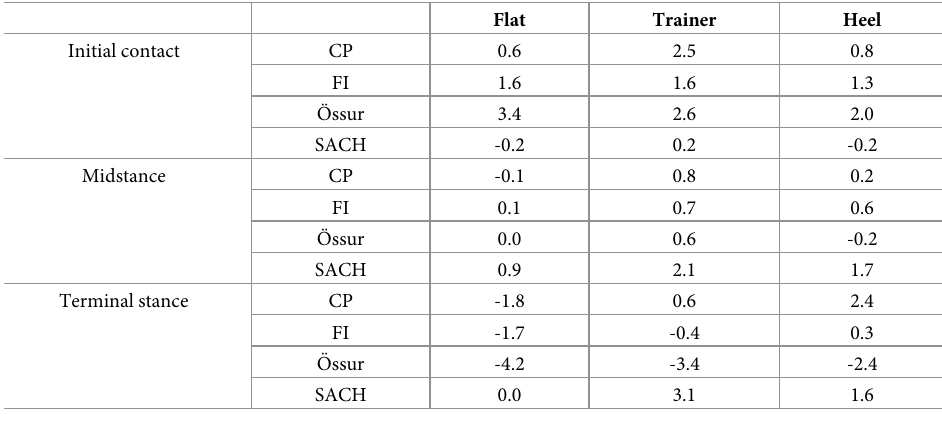
Table 2. Energy returned relative to barefoot